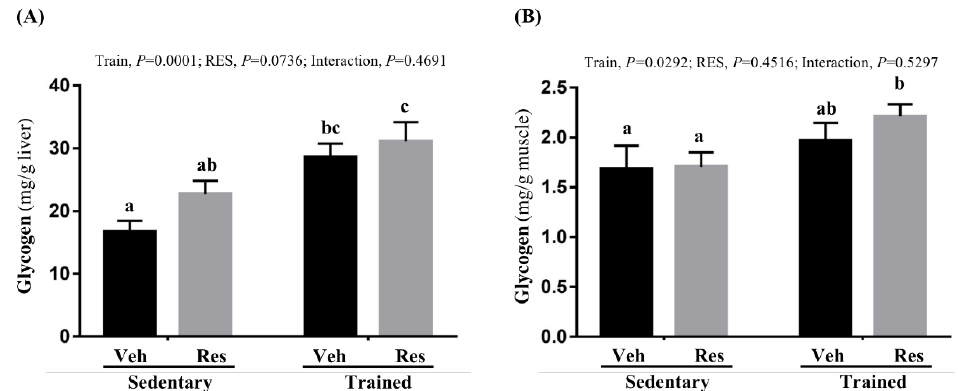
Figure 6. Effect of climb training (Trained) and/or resveratrol (RES) supplementation on hepatic ( A ) and muscle ( B ) glycogen level. Data are mean ± SEM for n = 10 mice per group. Bars with different superscript letters (a, b, c) are significantly different at P < 0.05. The abbreviations Veh and RES represented the vehicle and resveratrol supplement, respectively.